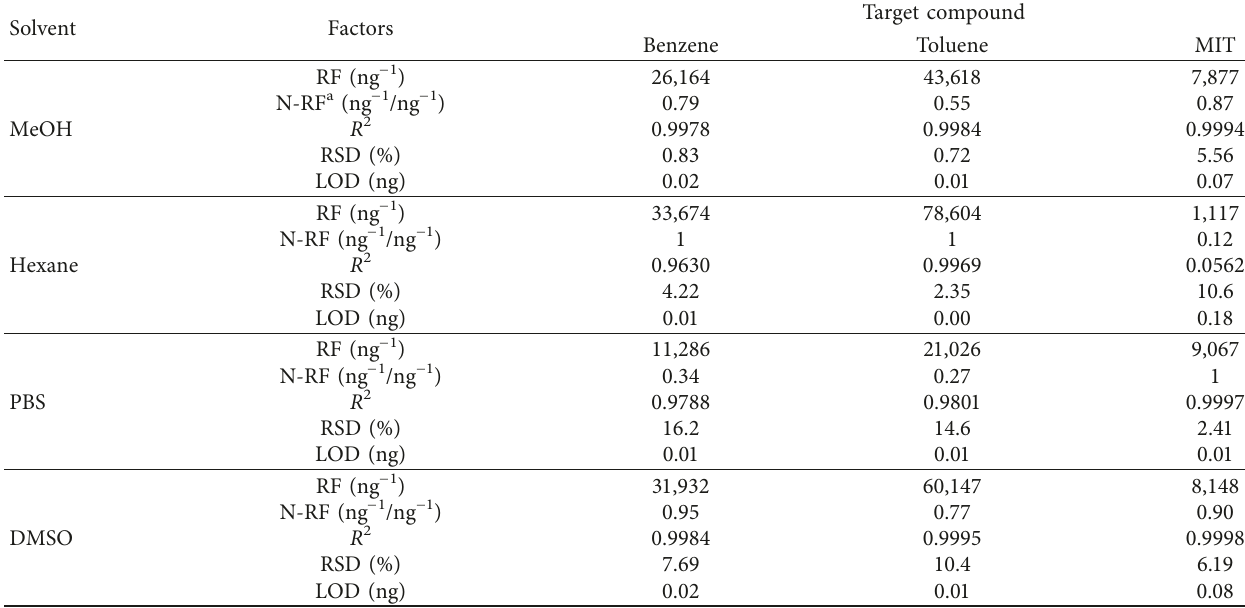
Table 4: Experimental results for three target compounds (benzene, toluene, and MIT) based on four different solvents (MeOH, hexane, PBS, and DMSO), including the response factor (RF, ng − 1 ), normalized-RF (N-RF, ng − 1 /ng − 1 ), determination of correlation ( R 2 ), relative standard deviation (RSD, %), and limit of detection (LOD,